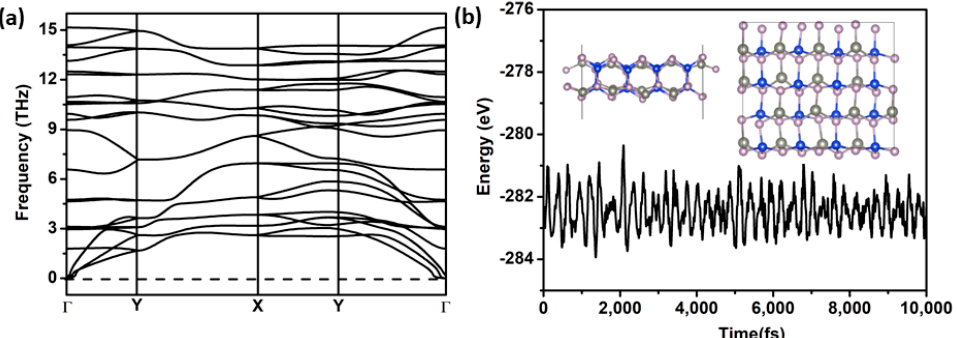
Figure 2. ( a ) The phonon spectra of the ZnSiP 2 monolayer. ( b ) Vibration of total potential energy of ZnSiP 2 during the AIMD (400 K). The inset is the final snapshot of ZnSiP 2 at the end of 10 ps. Additionally, we further calculated the four independent elastic constants of the ZnSiP 2 monolayer, which were C 11 = 106.2 Nm − 1 , C 22 = 86.0 Nm − 1 , C 12 = 8.6 Nm − 1 , and C 44 = 26.1 Nm − 1 . According to the obtained elastic constants, the ZnSiP 2 monolayer satisfied the mechanical stability standard: C 11 > 0; C 44 > 0; C 11 C 22 > C 2 [37]. Moreover, 12 the diagrams for the in-plane Young’s modulus and Poisson ratio with polar angle [38] could be obtained and are depicted in Figure 3, showing that the ZnSiP 2 monolayer is anisotropic. The maximum Young’s modulus (105 N/m) was higher than that reported for phosphorene (92 N/m) [39] and comparable to those of MoS 2 (129 N/m) [40] and V 2 Te 2 O monolayers (115.3 N/m) [41]. The anisotropy characteristic of mechanical properties also has an important effect on electronic